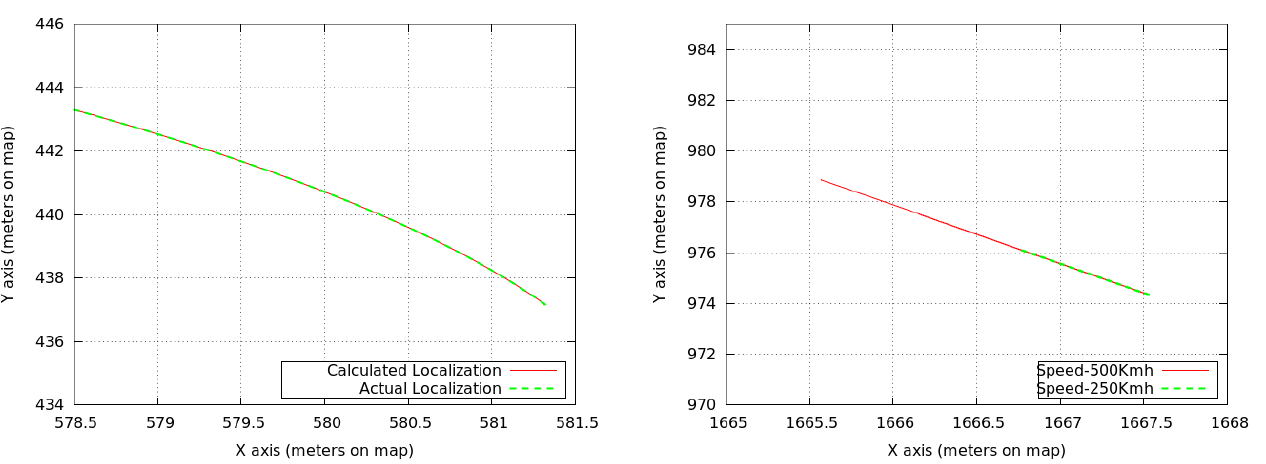
Figure 12. Graph of circular mobility